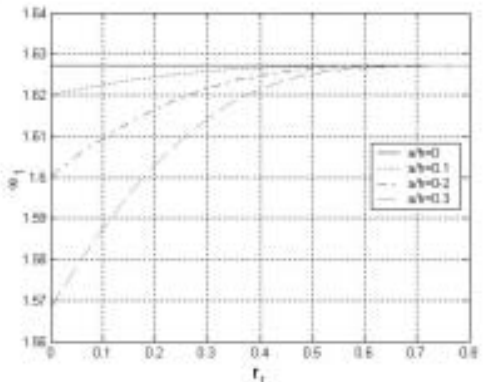
Fig. 2. The first structural frequency parameter of the coupled system as a function of the position of the crack. The fluid is considered to be incompressible without sloshing.